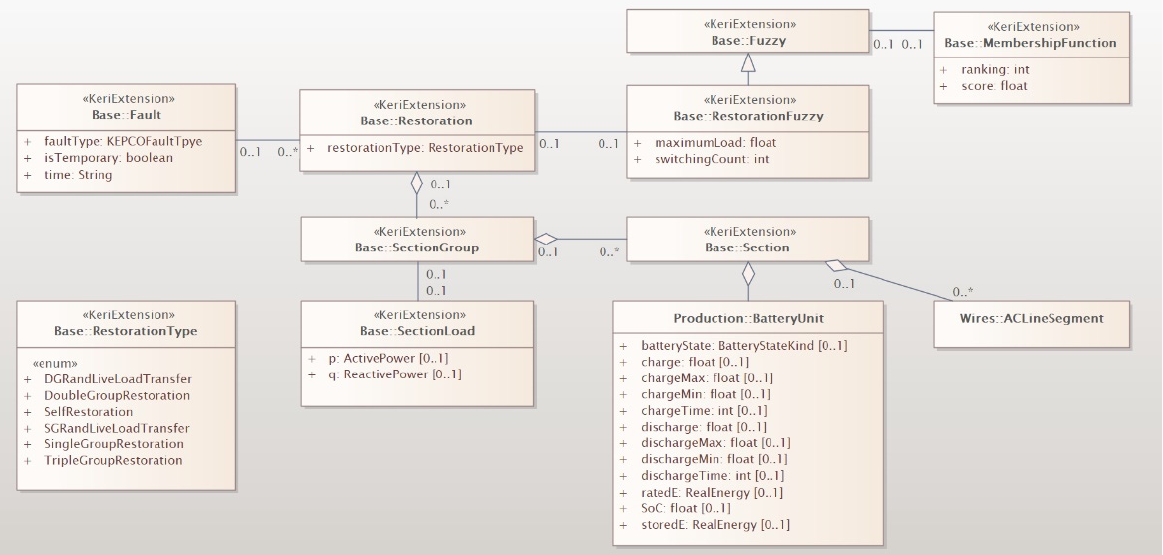
Figure 15. ( a ) Profile of the prediction of generation and load; ( b ) Payload of the prediction of generation and load.